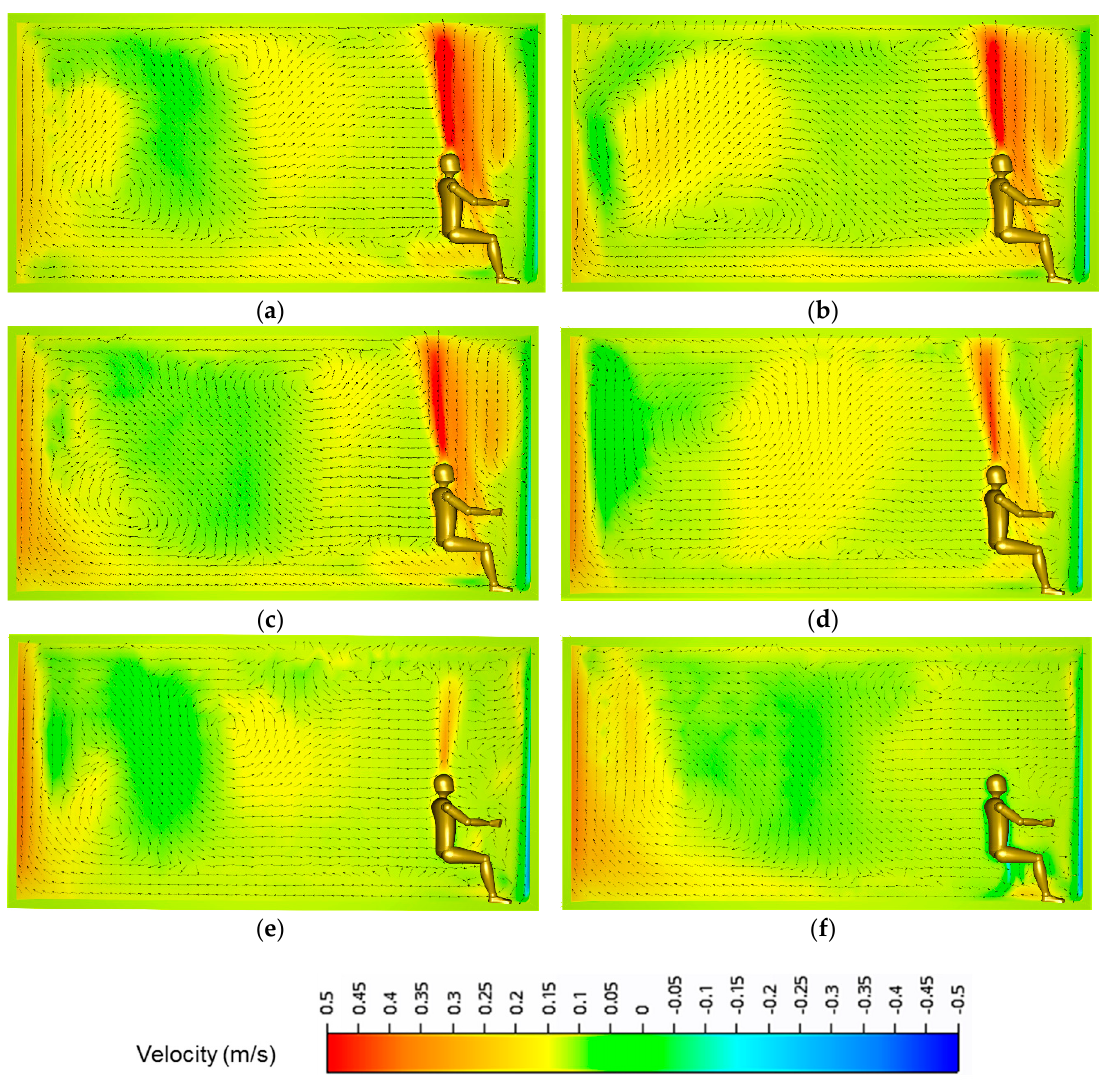
Figure 11. Velocity contour (x-y plane, z = 2 m) of the CFD simulations for the ceiling temperatures of 20 °C ( a ), 25 °C ( b ), 28 °C ( c ), 33 °C ( d ), 38 °C ( e ) and 45 °C ( f ) in the scenario with one low-performance façade.